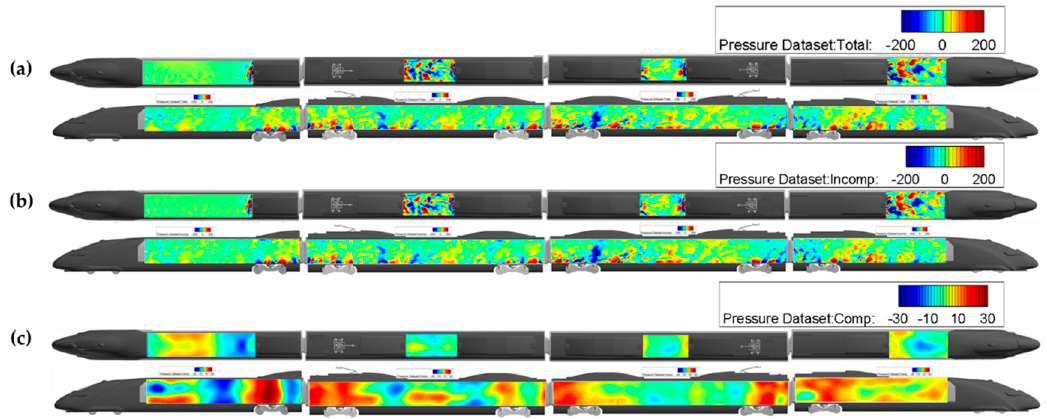
Figure 19. Decomposed instantaneous surface pressure field at time domain: ( a ) original total pressure field; ( b ) decomposed incompressible pressure field; ( c ) decomposed compressible pressure field.